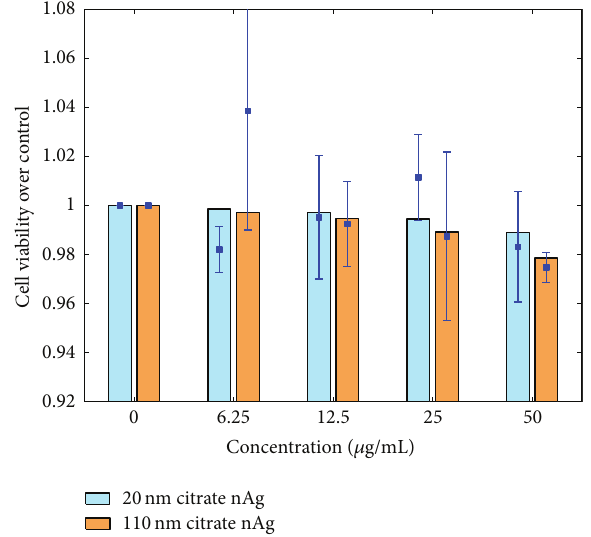
Figure 6: Comparison between model prediction and in vitro measurement for human alveolar macrophage cell viability, 24 hours after incubation. Bars represent model predictions and squares and error bars represent in vitro measurements.